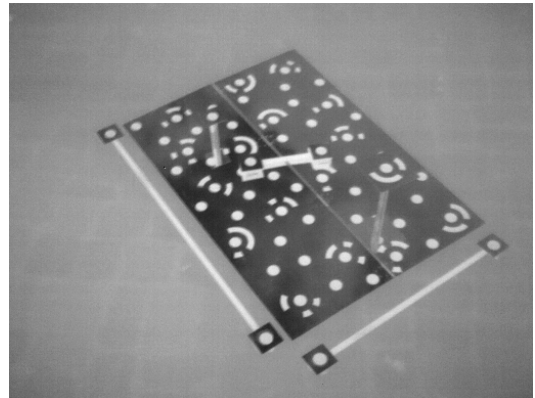
Figure 3: Aluminium calibration field with adhesive coded tar- gets, including a few elevated targets for a better geometric con- figuration.